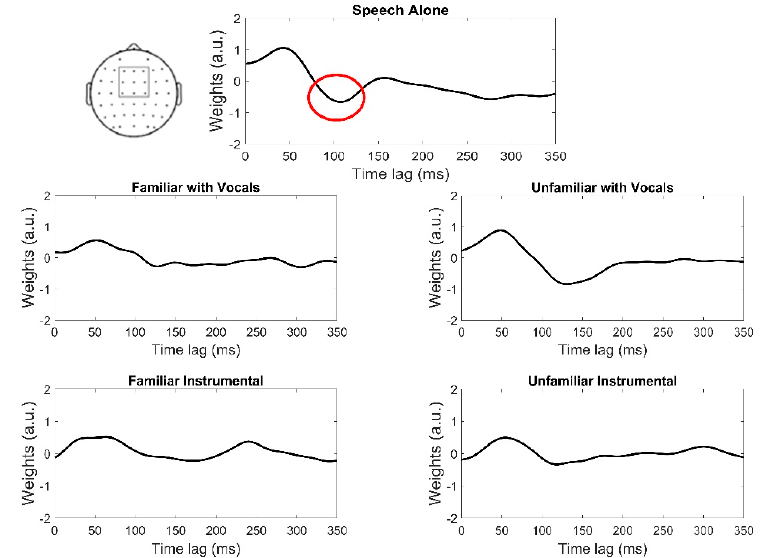
Figure 1. Grand average TRF waveforms (plotted at channel FCz) across music masker conditions. The model was trained using a fronto-central cluster of electrodes (top left). Red circle = region of interest for analyses corresponding to the auditory N1.